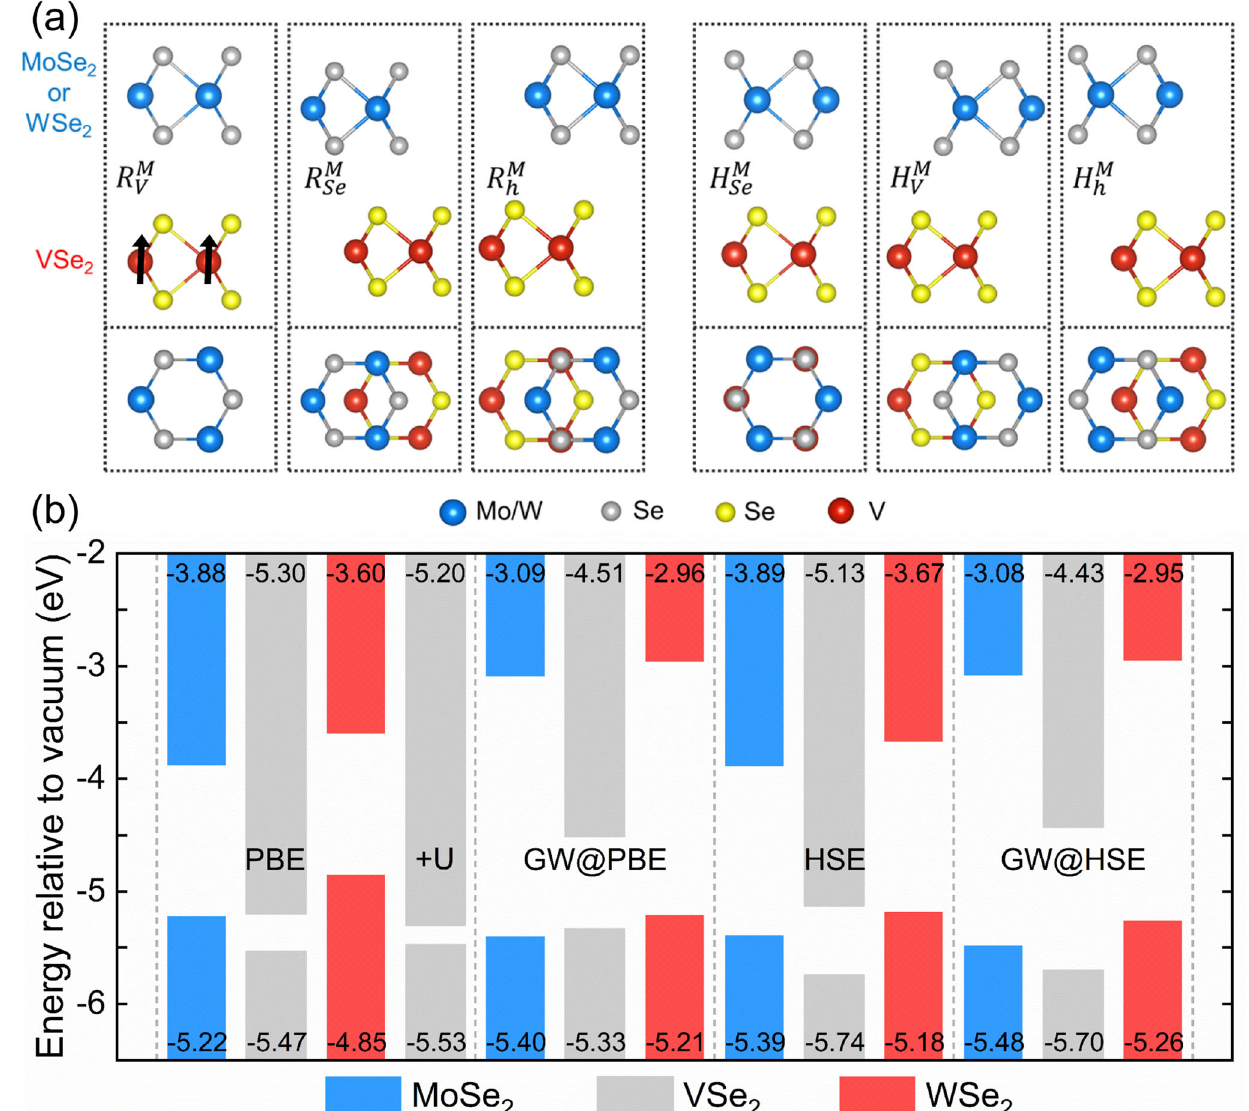
Fig. 1 Stacking structures and band alignment of MSe 2 /VSe 2 heterostructures. a Schematic top- and side-view of three R-type and three H-type heterobilayer registries. The Se atoms from MSe 2 and VSe 2 layers are shown in different colors. b Band edges relative to the vacuum energy level (set to zero) within different approximations for MoSe 2 , WSe 2 , and VSe 2